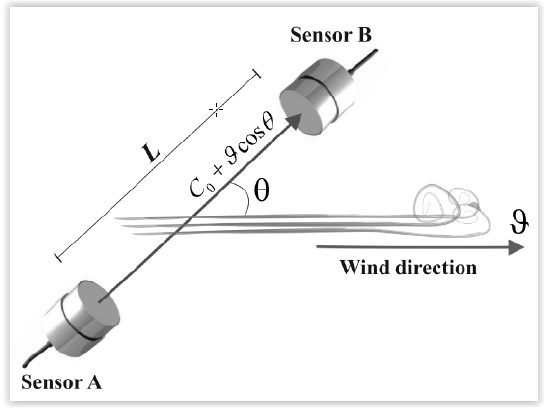
Figure 7. Wind speed measurement sensor configuration.